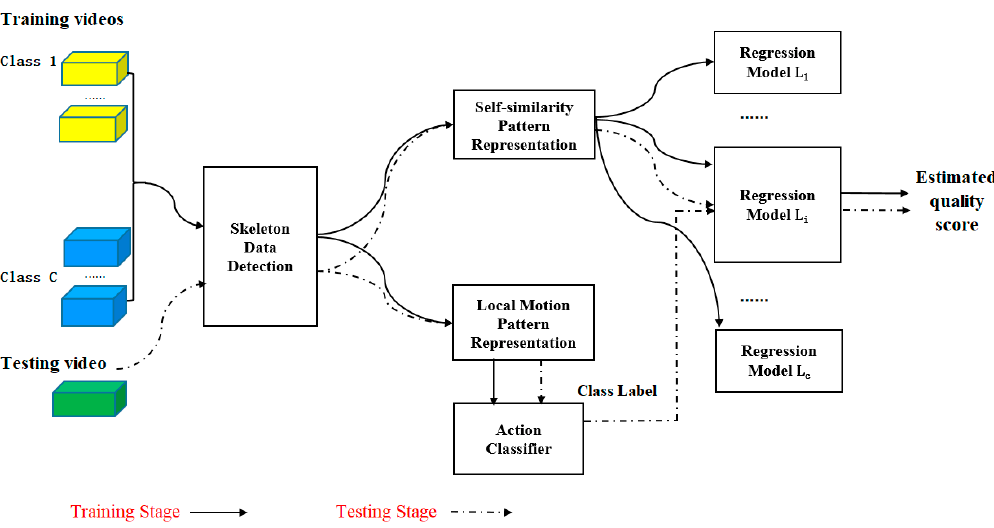
Figure 1. The framework of our action quality assessment method. (The input data were RGB videos of diverse action categories. Skeleton data detection: OpenPose algorithms provided by the work of Reference [21] were performed to capture skeleton data from the RGB video. Local motion pattern representation: the local motion pattern was extracted from each joint movement volume and aggregated to train the action classifier. Action classifier: the Support Vector Machine (SVM) classifier was developed from labeled training samples to determine the class label of the action video. Self-similarity pattern representation: we developed self-similarity feature descriptors extracted from joint trajectories and joint displacement sequences to represent the periodic property of sport activities. Regression models: we employed a class-specific learning strategy, and trained multiple regression models specific to different action categories for action quality score estimation.).